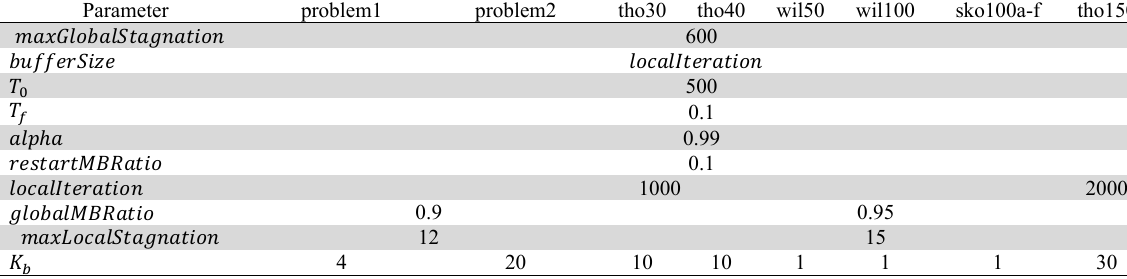
Parameter setting for the numerical